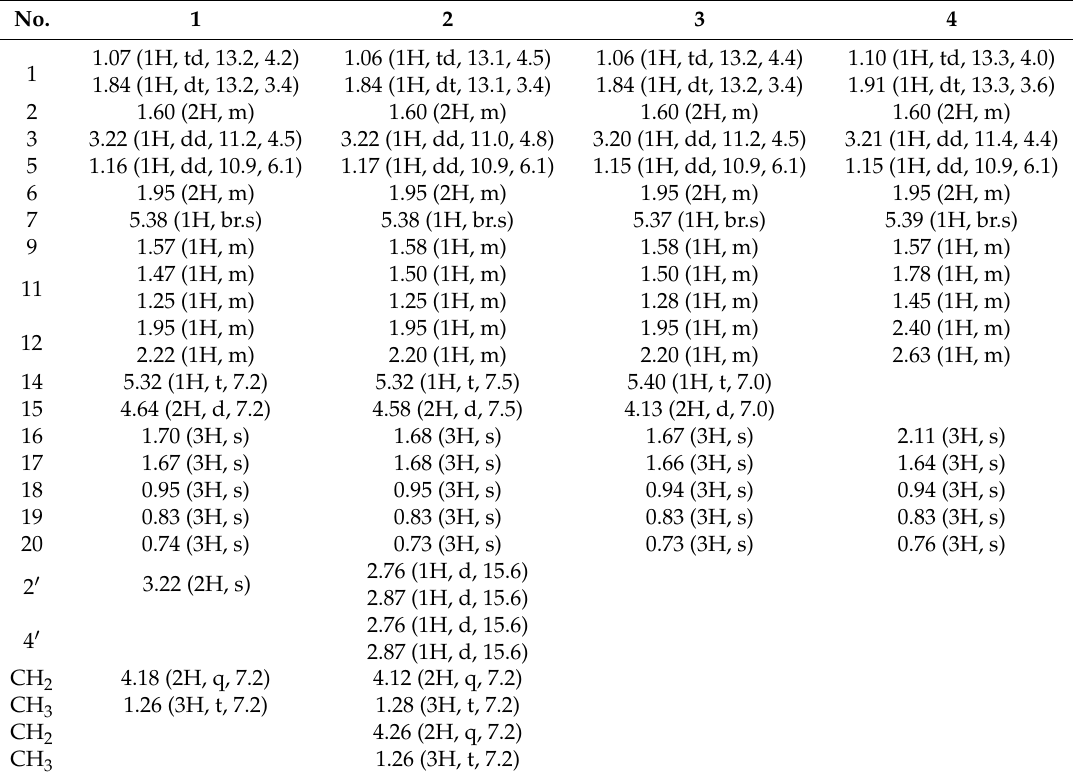
Table 1. 1 H-NMR data (500 MHz, δ in ppm, J in Hz) of compounds 1 – 4 in CDCl 3 .